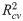
Dependence of encoding model analysis on regularization and the number of included model features.(A-C) Percent correct model selections using either Rcv2 (solid line) or correlation (dashed line) for encoding models without a prior (blue lines) and with a prior (red line). (D-F) Correlation between predicted and observed patterns. (G-I) Predictive Rcv2 for the encoding models with prior. All Rcv2 values for models without prior are negative, and therefore not visible.